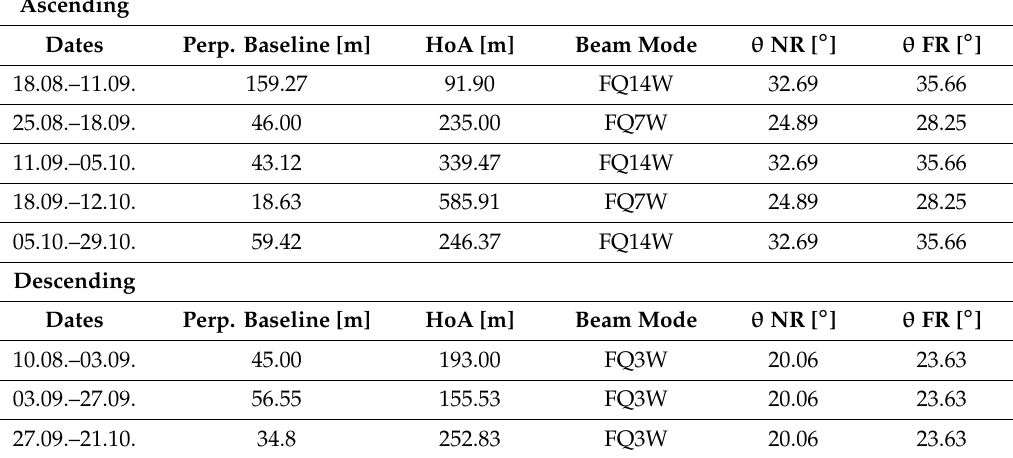
Table 1. RS-2 data and the di ff erent acquisition parameters from 2015 applied in the study. (Date format angle in far range (FR) and near range (NR).